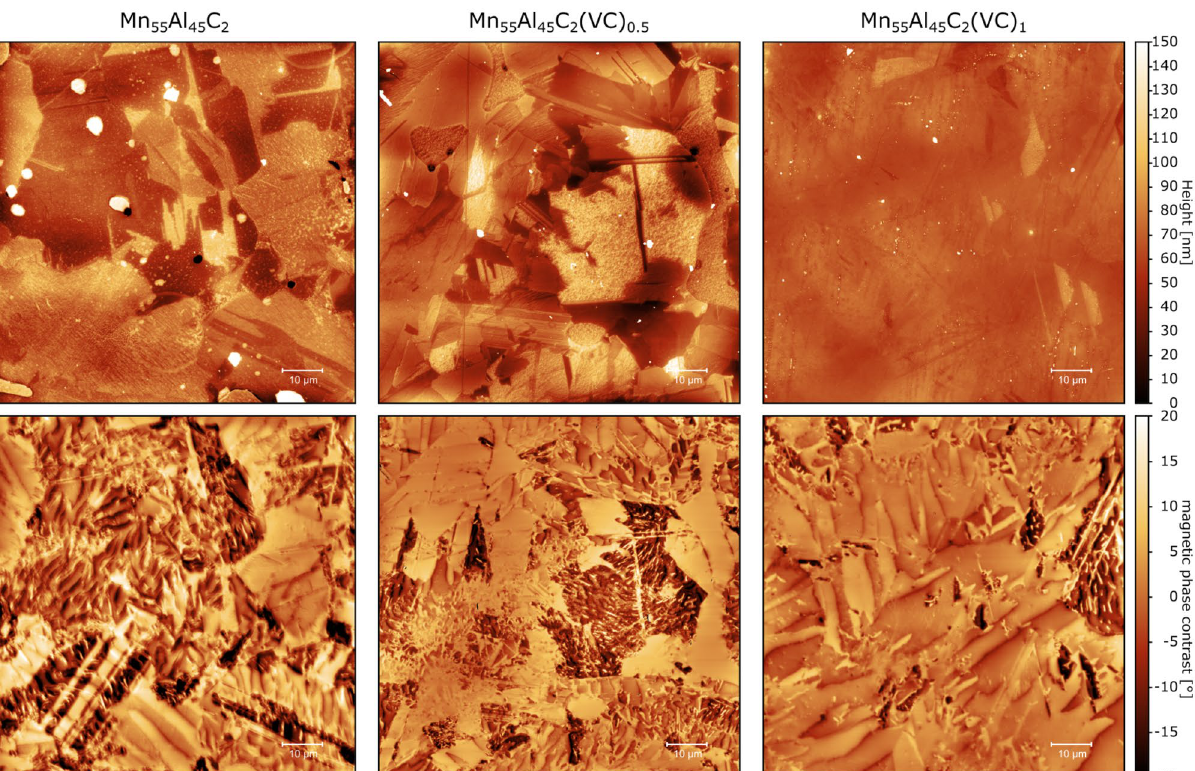
Figure 6. Representative results from MFM measurements of Mn 55 Al 45 C 2 , Mn 55 Al 45 C 2 (VC) 0.5 and Mn 55 Al 45 C 2 (VC) 1 . First row shows the topography of the measured sample, while the second row represents the magnetic contrast illustrating the magnetic domain structure at the measured